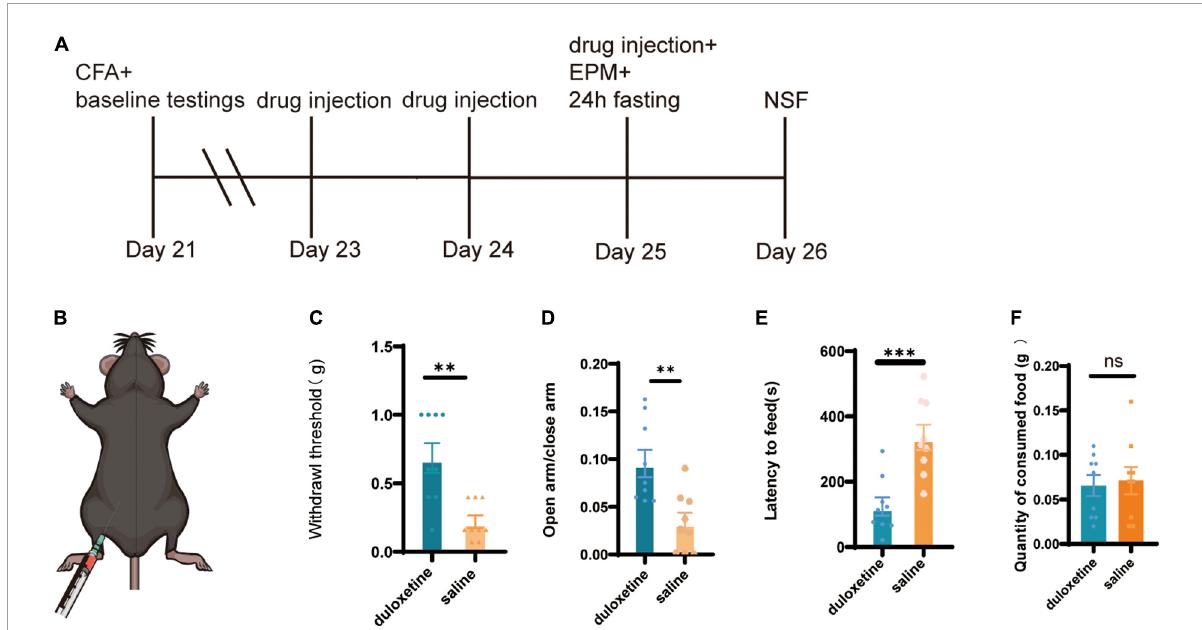
FIGURE3 Systemic duloxetine improved mechanical withdrawal threshold and anxiety-like behaviors in mice with chronic inflammatory pain. (A) Timeline of duloxetine injection and subsequent behavioral tests. (B) Intraperitoneal injection of duloxetine. (C) Withdrawal threshold of duloxetine and saline group after a 3-day injection ( n = 9, p = 0.0012, unpaired t -test). (D) The ratio of time in the open arm to closed arm of duloxetine and saline groups ( n = 9, p = 0.0012, unpaired t -test). (E) Latency to feed of duloxetine and saline groups ( n = 9, p = 0.0004, unpaired t -test). (F) Quantity of consumed food in home cage feeding test ( n = 9, p = 0.7751 unpaired t -test).